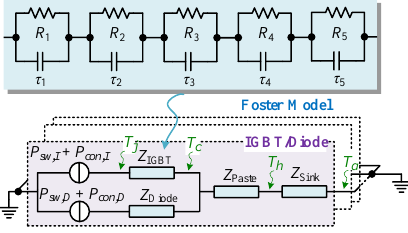
Figure 2. Detailed thermal model of a PV inverter using a discrete IGBT diode pack [40]. Table 4. Diode and IGBT (IKW60N60H3) Foster